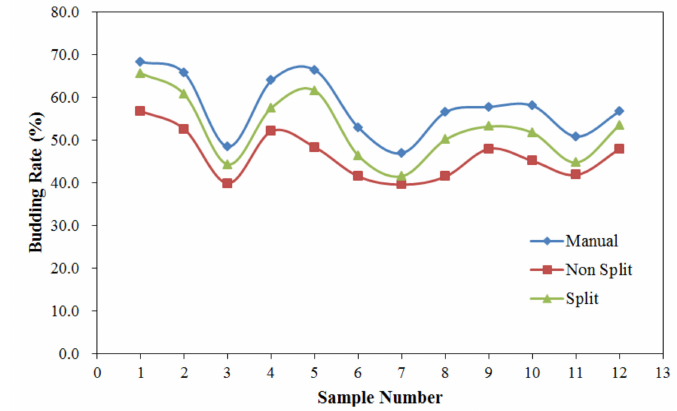
Figure 6. The budding rates of the validation samples obtained from the three